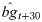
Illustration of a decision tree used for regression.Intermediate nodes represent tests of the features and leaf nodes are predictions for bg^t+30.